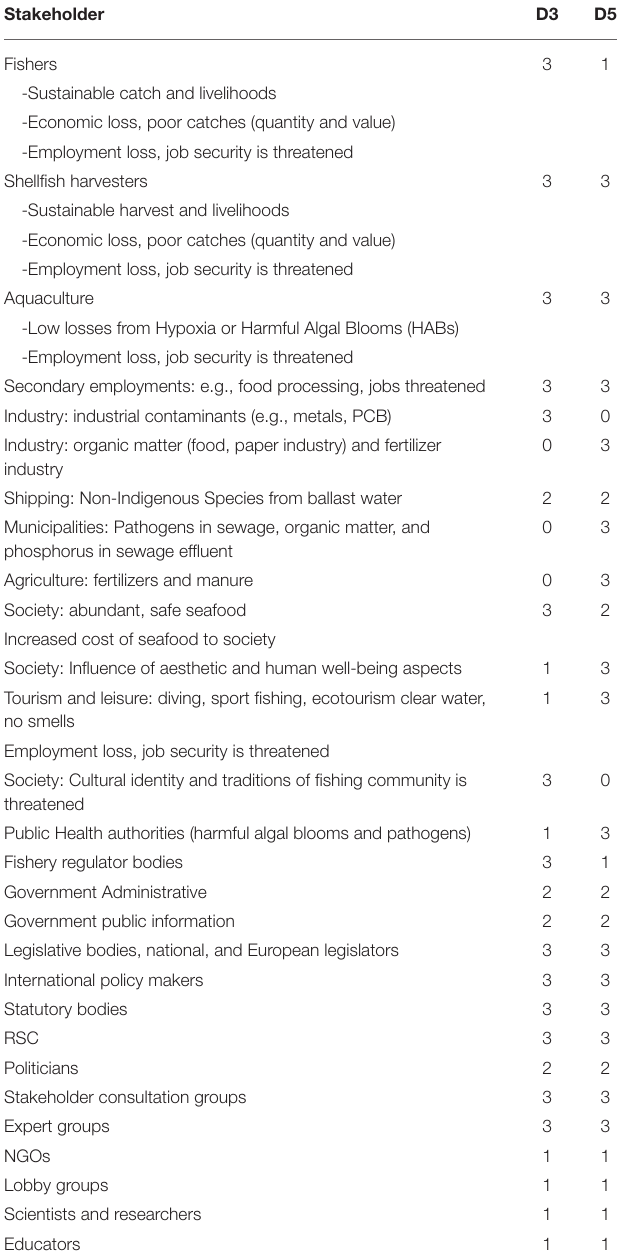
TABLE 5 | Example weightings (0 low–3 high) of different stakeholders for two MSFD Good Environmental Status Descriptors (D3 commercial species and D5